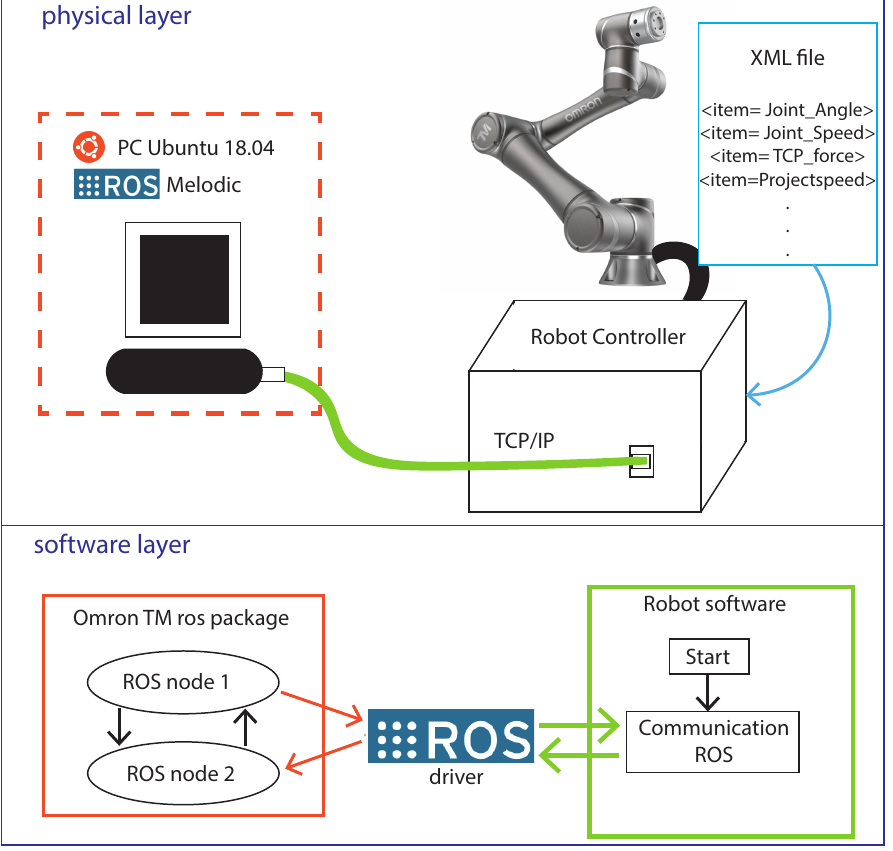
Figure 1. Connection schematic